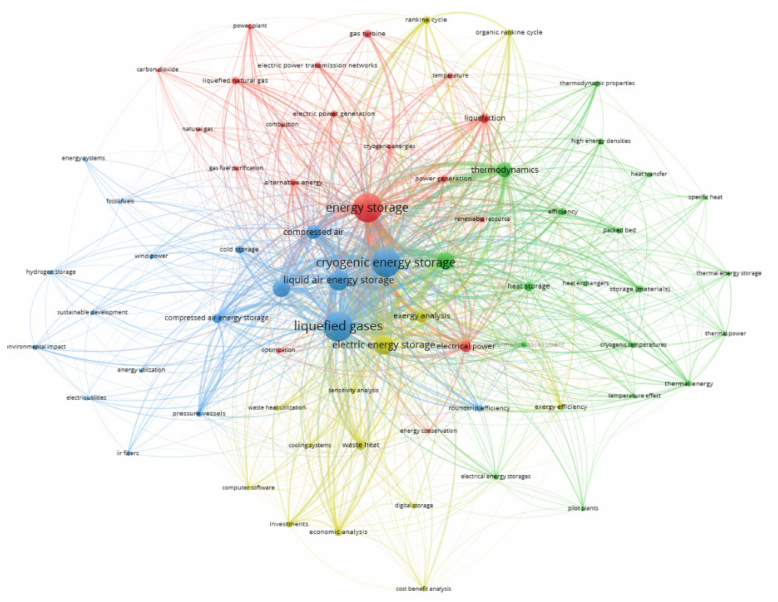
Figure 13. Co-occurrence and link of the keywords elaborated with